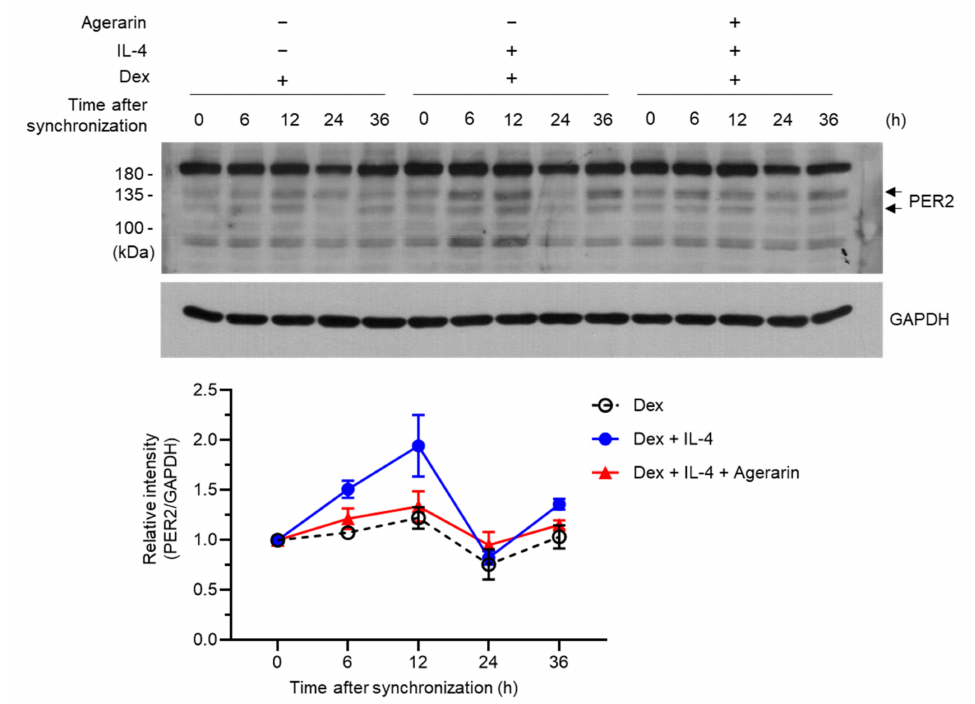
Figure 6. Effect of agerarin on the suppression of IL-4-induced PER2 expression in HaCaT cells synchronized with Dex. HaCaT cells were synchronized with 100 nM Dex for 2 h, followed by